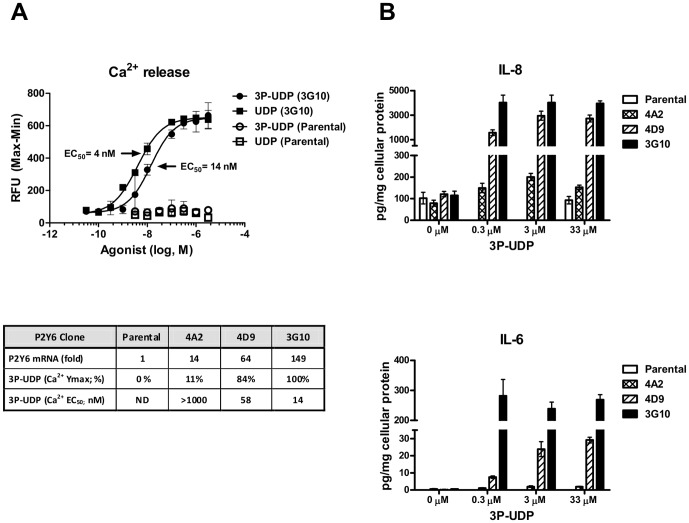
P2Y6 expression mediates release of calcium and pro-inflammatory cytokines in 1321N1 cells.Evaluation of calcium release and cytokine secretion to cell culture media in 1321N1 astrocytoma cells stably expressing human P2Y6 receptor. A) Isolated 1321N1 clones expressing varying levels of P2Y6 mRNA and mock transfected cells (Parental) were incubated with increasing concentrations of UDP and 3P-UDP. Calcium mobilization was measured to generate concentration response curves with examples shown for 3G10 clone and parental cell line. For each clone, achieved maximal calcium response is expressed as percentage relative to 3G10 clone (set as 100%) together with calculated EC50 values (ND  =  not determined) and relative P2Y6 mRNA levels (relative to parental cells, which had very low but detectable P2Y6 mRNA). B) 1321N1 clones were incubated for 20 hr with increasing concentrations of 3P-UDP and cytokines in cell culture medium quantified using multiplex ELISA as described in Materials and Methods. Each cytokine was normalized to cellular protein content. The data are presented as mean +/− SD of replicate wells.